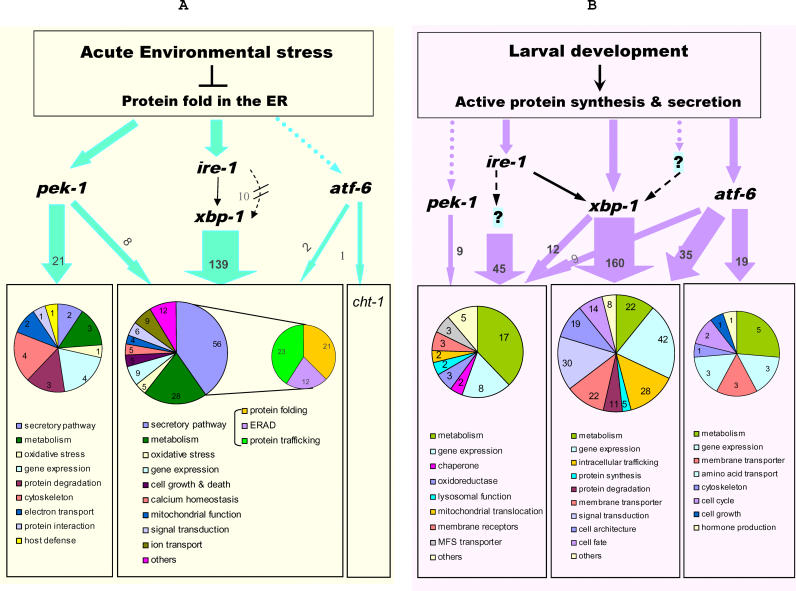
Complex UPR Transcriptional Regulation of Genes with Known Functions in C. elegans
(A) The i-UPR pathway. Many conditions such as exogenous drug treatment, nutrient deprivation, viral infection, or protein overexpression block or overwhelm protein-folding reactions in the ER and result in ER stress. In this study, we used tunicamycin to block protein folding so as to activate the UPR. Following ER stress, ire-1 and xbp-1 act in a linear pathway that dominates the transcriptional response (total of 139 target genes with known functions), inducing genes that reshape the secretory pathway, adjust the metabolic profile, up-regulate functions involved in calcium homeostasis and anti-oxidative stress, and regulate other genes that might affect cell fate. Interestingly, ten genes require either ire-1 or xbp-1, but not both, for their induction upon ER stress. About 21 genes require only pek-1 for maximal induction, and eight genes regulated by ire-1/xbp-1 also share regulation by pek-1. Finally, atf-6 does not play a significant role in the i-UPR pathway (depicted by broken arrow). In addition to two genes that were also regulated by ire-1/xbp-1, the only gene that depends solely on atf-6 for its induction is cht-1, which encodes a chitinase orthologous to human chitotriosidase.(B) The c-UPR pathway. During development, active protein synthesis and secretion require the UPR signaling molecules ire-1, xbp-1, and atf-6 to maintain the expression of c-UPR genes, defined by the fact that they are not up-regulated by tunicamycin but are dependent on ER stress transducers for expression. Among the genes with known functions, there are only 12 that overlap between the set of 45 genes regulated by ire-1 and the set of 160 genes regulated by xbp-1. In addition, atf-6 is required by nine genes that are regulated by ire-1 and 35 that are genes regulated by xbp-1. Moreover, the expression of 19 genes is solely dependent on atf-6, suggesting an important role of atf-6 in the c-UPR pathway. By contrast, pek-1 is largely dispensable for regulation of the c-UPR as only nine genes require pek-1 in addition to their requirements for ire-1 to maintain basal expression.